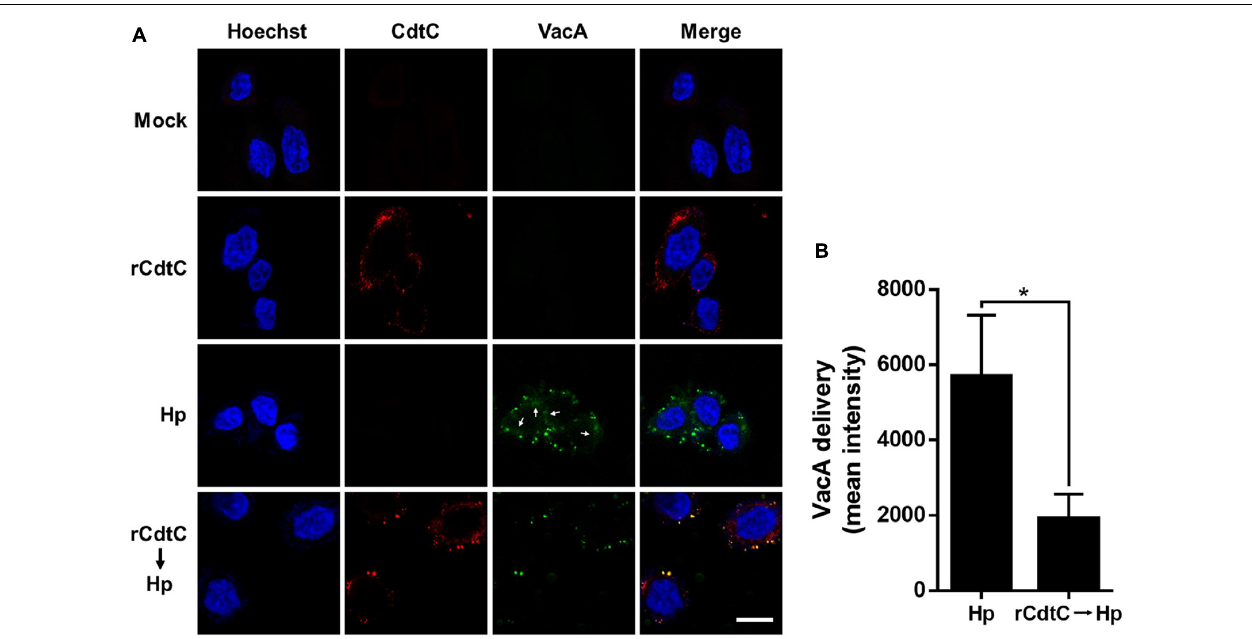
FIGURE 2 | rCdtC declines Helicobacter pylori VacA delivery in cells. AGS cells (A) pre-incubated with rCdtC (200 nM) were infected with or without H. pylori at a multiplicity of infection of 100 for 6 h. The cells were stained with anti-CdtC (red) and anti-VacA (green), and the nuclei were probed with Hoechst 33342 (blue). The image was observed under a confocal microscope with a 63 × oil immersion objective and processed by software ZEN (Carl Zeiss, Germany). Arrows indicate VacA delivered into the cytoplasm. Scale bar, 10 µ m. (B) The delivery of VacA into the cytoplasm was quantified. Green puncta representing VacA localized on the bacterial surface were excluded from the fluorescence intensity analysis. The quantification represented in the figures reflected the mean pixel intensity of the VacA signal in the cytoplasm of each cell (50 cells were analyzed per sample). * P < 0.05.